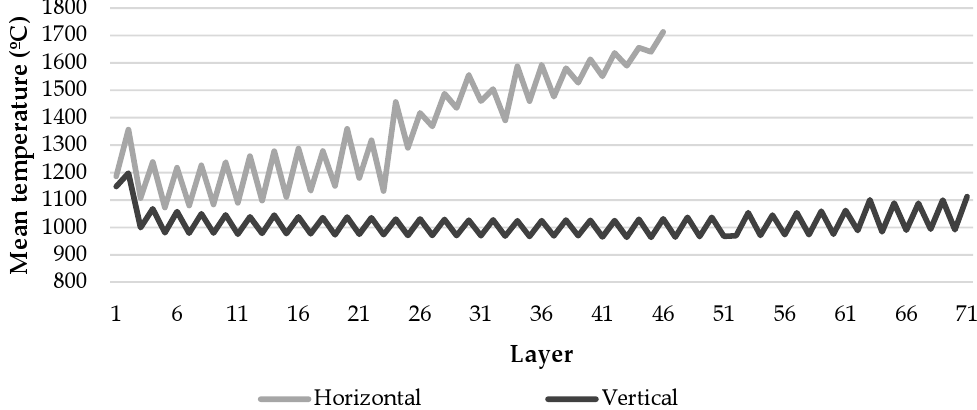
Figure 16. Mean melt pool temperature of layers in parts manufactured to test mechanical properties with Argon Q1 + 18 L/min + hatching condition.